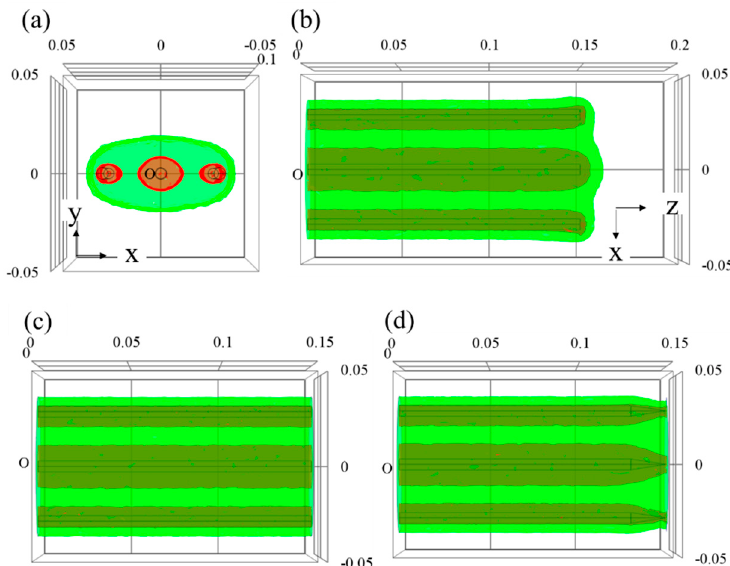
Figure 9. Contour surfaces of 90% (green) and 50% (red) sample volume. ( a ) Cross section view of model N2; ( b ) top view of model N2; ( c ) top view of model N3; and ( d ) top view of model N4. ( c ) and ( d ) have the same coordinates as ( b ). The unit of the dimensions of the model is m.